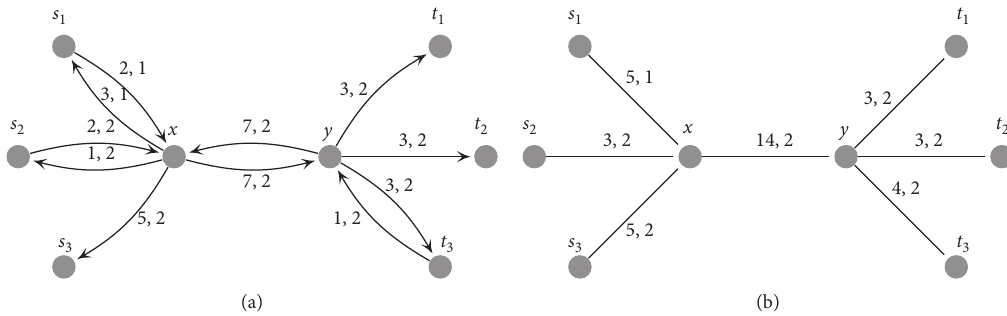
Figure 1: Auxiliary network (b) of the given network (a). (a) Capacity, transit time; (b) capacity, transit